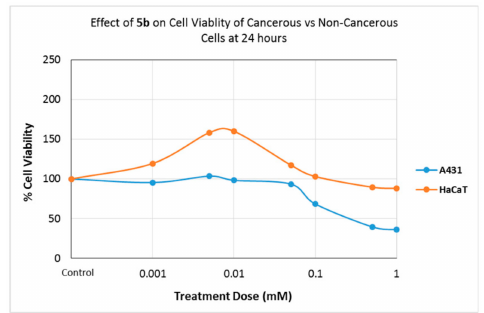
Figure 1. E ff ect of 5b on cell viability of cancerous vs. noncancerous cells at 24 h.